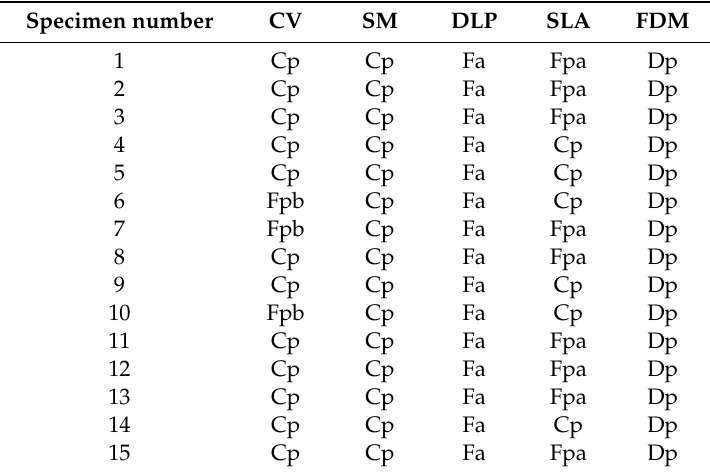
Table 3. Classification of characteristic patterns of cracks and fractures.